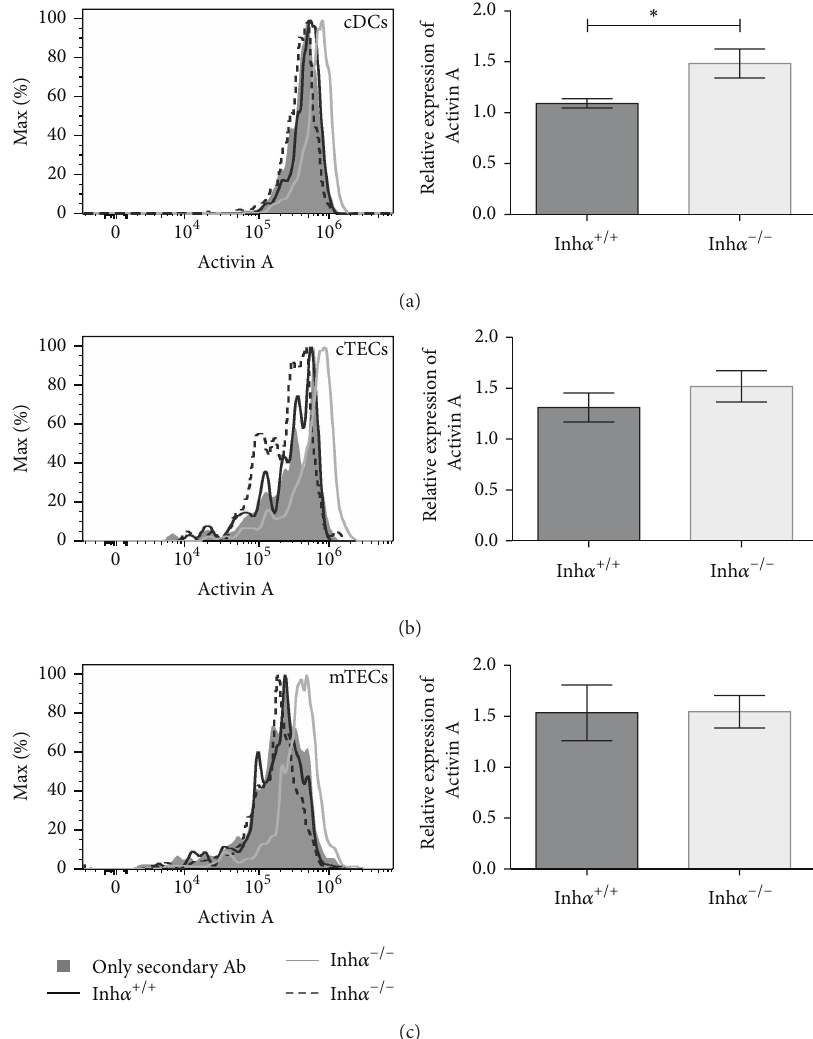
Figure 5: Inh 𝛼 −/− thymic cDCs display increased intracellular levels of Activin A. The histograms show the intracellular Activin A expression in cDCs (a), cTECs (b), and mTECs (c) derived from Inh 𝛼 +/+ and Inh 𝛼 −/− mice; for each histogram two Inh 𝛼 −/− (gray and dashed lines) and one Inh 𝛼 +/+ mice (black line) were represented. (a, b, c right) summary of data showing the expression (MFI) of Activin A relative to the secondary antibody staining in the different cell subpopulation analyzed. One representative histogram from Inh 𝛼 +/+ ( 𝑛 = 5 ) and Inh 𝛼 −/− ( 𝑛 = 6 ) mice analyzed is shown. Statistical significance: ∗ 𝑃 ≤ 0.05